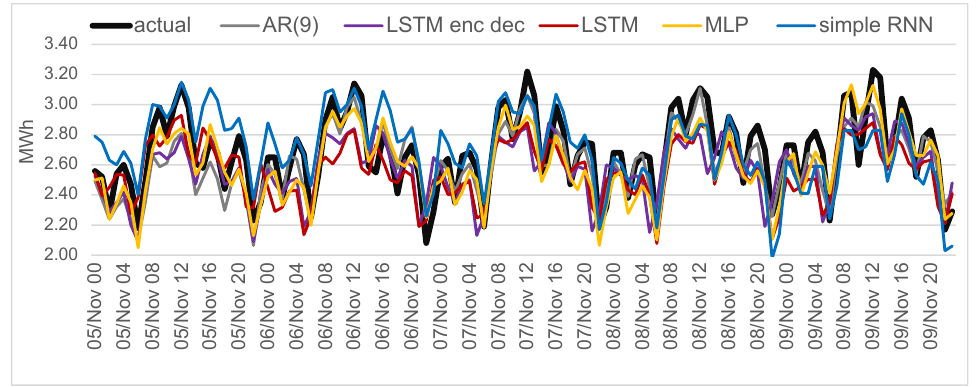
Figure 7. Comparison between the actual and the forecasted values with AR, LSTM encoder-decoder, LSTM, MLP and simple RNN